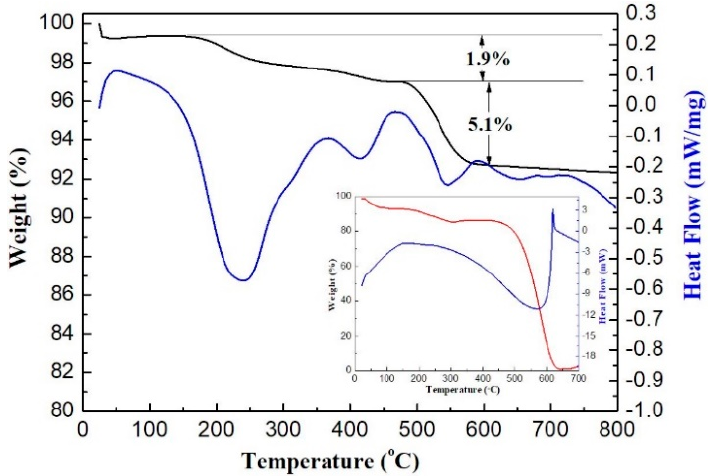
Figure 4. Thermogravimetry–differential scanning calorimeter (TG–DSC) profiles of g-C 3 N 4 and MgFe 2 O 4 /g-C 3 N 4 -10 composites.